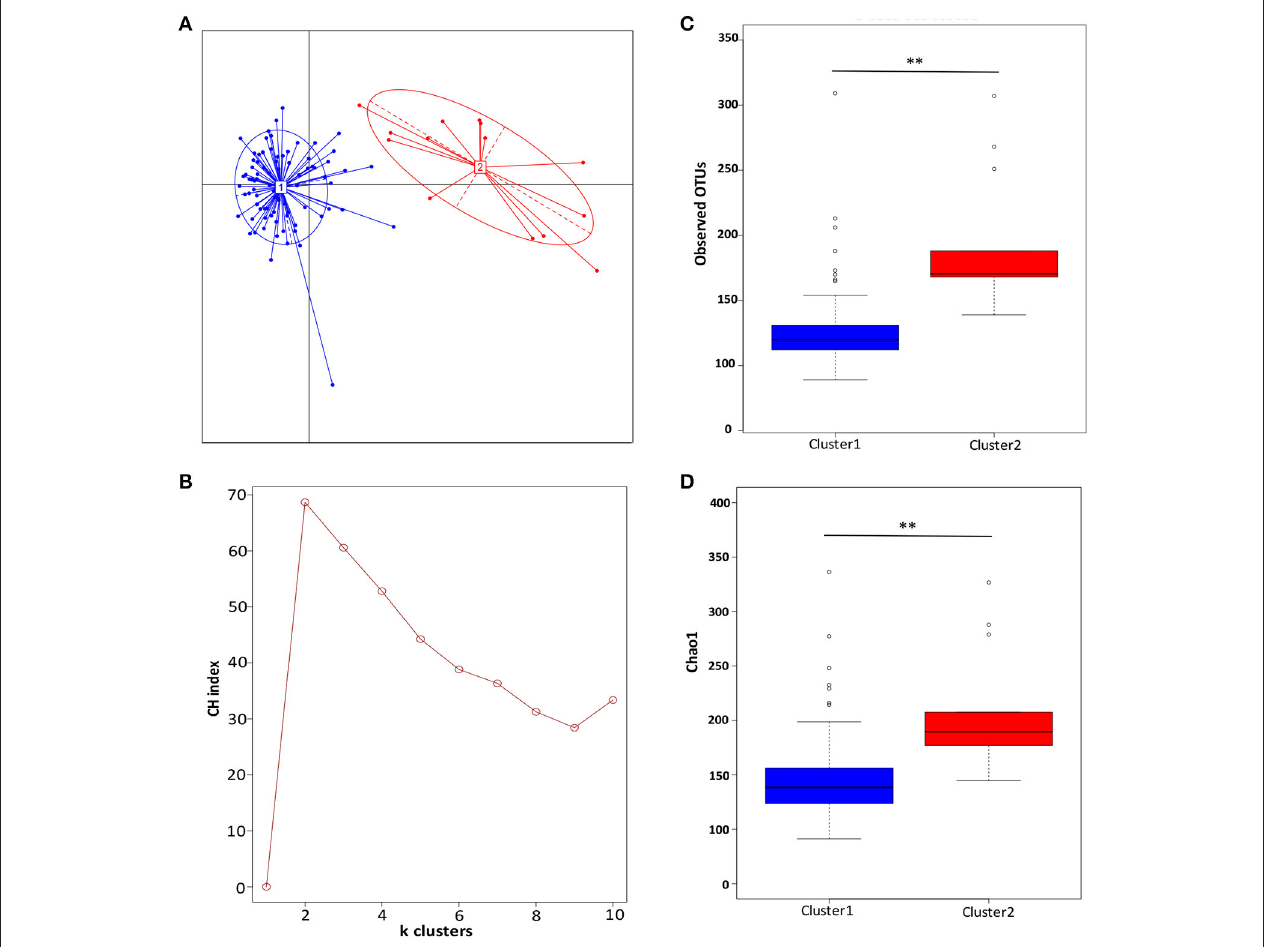
FIGURE 1 | Two clusters were observed in ascitic fluids microbiota. (A) The principal coordinate analysis of the Jensen-Shannon distance generated from the OTU-level relative abundance profiles. Samples are colored by clusters identified by the partitioning around medoids clustering algorithm. Dark blue, Cluster 1; red, Cluster 2. (B) Two clusters were supported with the highest Calinski-Harabasz (CH) pseudo F-statistic value, as the optimal number of clusters. (C) Boxplot comparison of the number of observed OTUs between Cluster 1 and Cluster 2. (D) Boxplot comparison of the Chao1 index between Cluster 1 and Cluster 2. ** p < 0.01 based upon Mann-Whitney U -tests with Benjamini & Hochberg